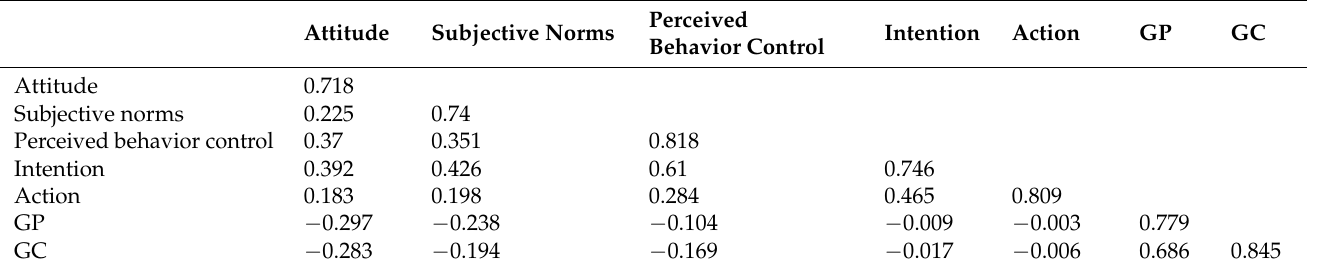
Table 3. Fornell–Larcker criterion test.